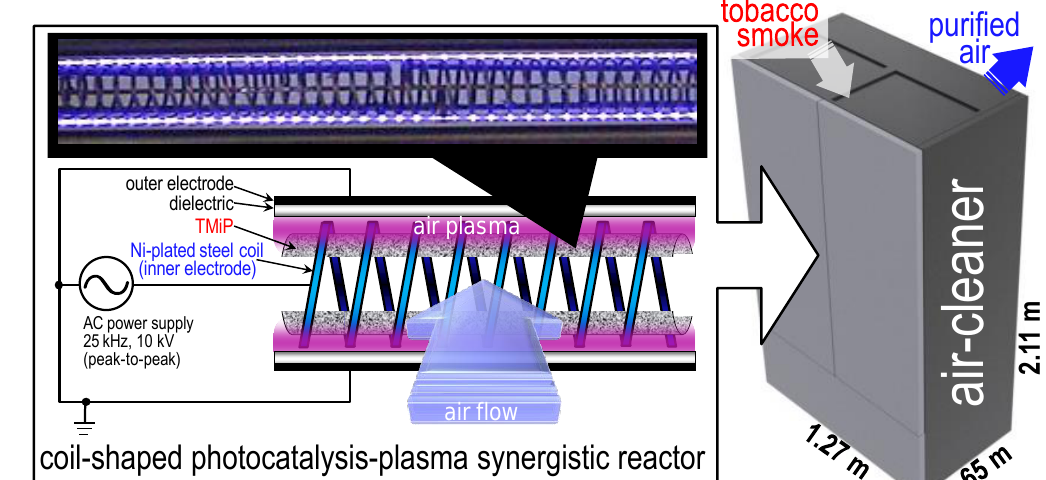
Figure 1. Image and schematic illustration of the coil-shaped PACT-TMiP synergistic reactor ( left ) and the air-cleaner ( right ). Reproduced from Ochiai et al. [4], published by Scientific Research Publishing Inc.,